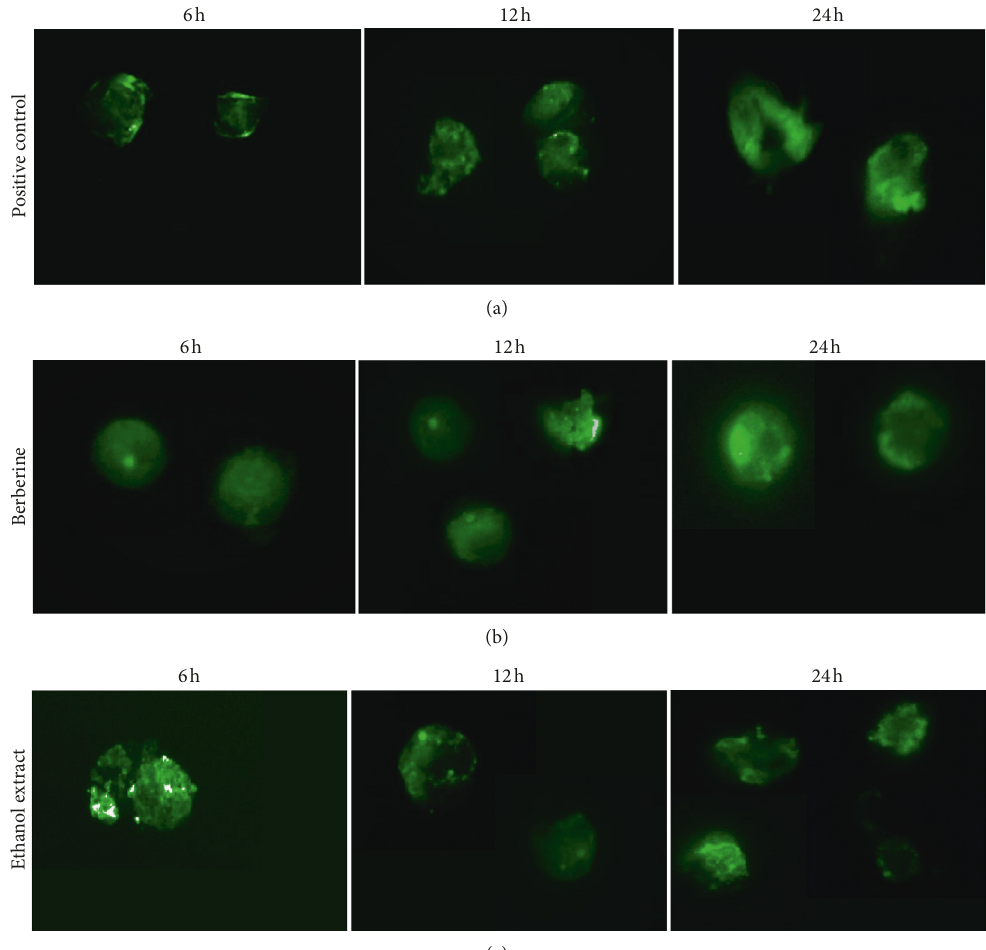
Figure 6: Photographs of annexin V-FITC-stained MCF-7 cells treated with the IC and 24 h. (a) Positive control; (b) Berberine; (c) Ethanol